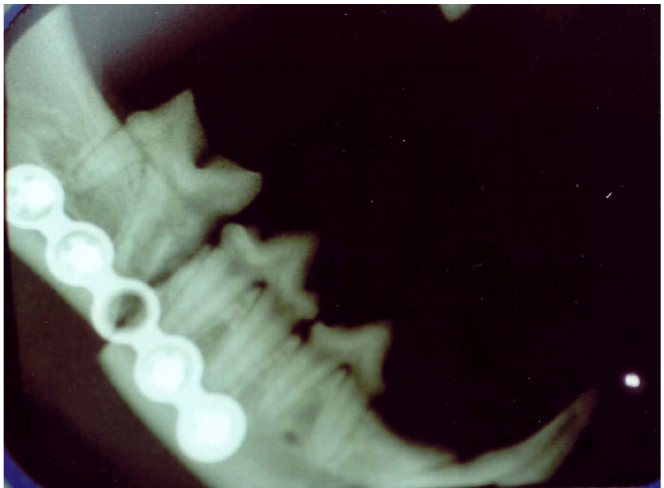
FIGURE 7 - Intraoral radiograph taken 1 week after surgery shows the radiolucent line corresponding to the osteotomy. Cat 10 of Group 2.